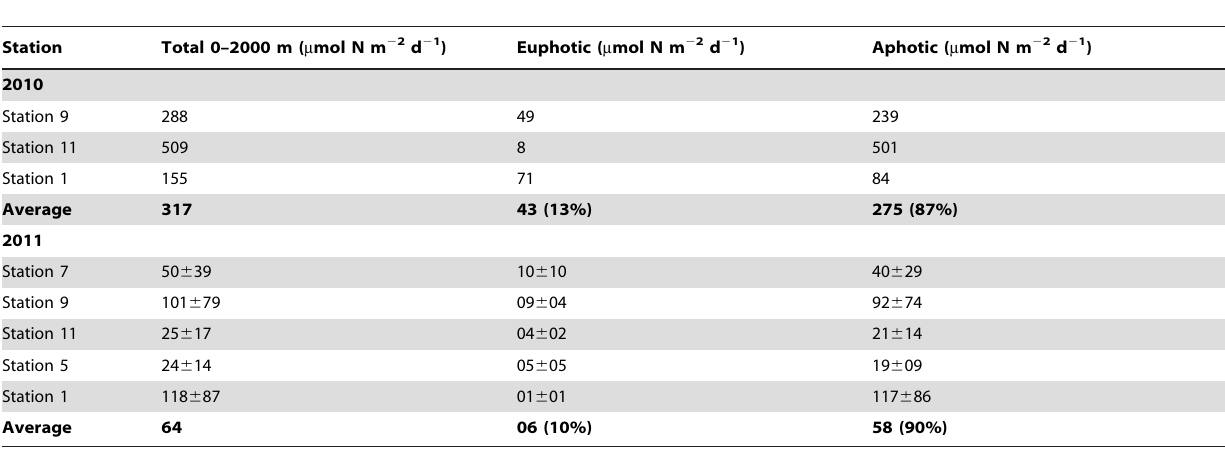
Table 1. Areal N 2 fixation rates ( m mol N m 2 2 d 2 1 ) calculated from measurements performed in the euphotic and aphotic zones during the 2010 and 2011